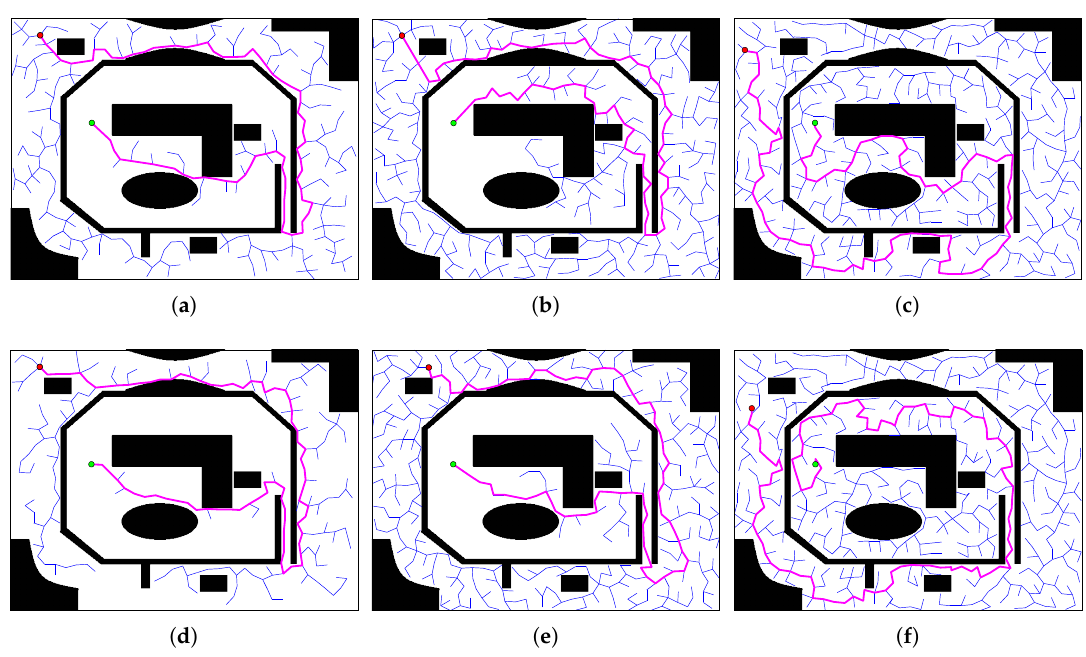
Figure 19. Comparison of the three algorithms. The blue lines are the trees, while the pink lines are the feasible paths. ( a , d ) The results of the ERRT method. ( b , e ) The results of the SRRT method. ( c , f ) The results of the proposed RRT method.